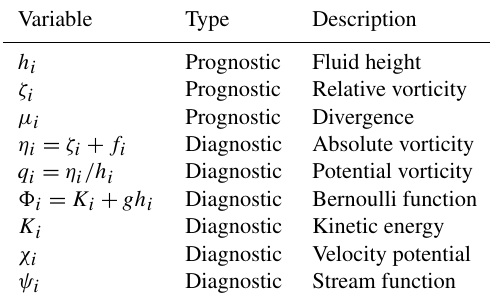
Table F1. List of discrete Z grid variables and their diagnostic equa-